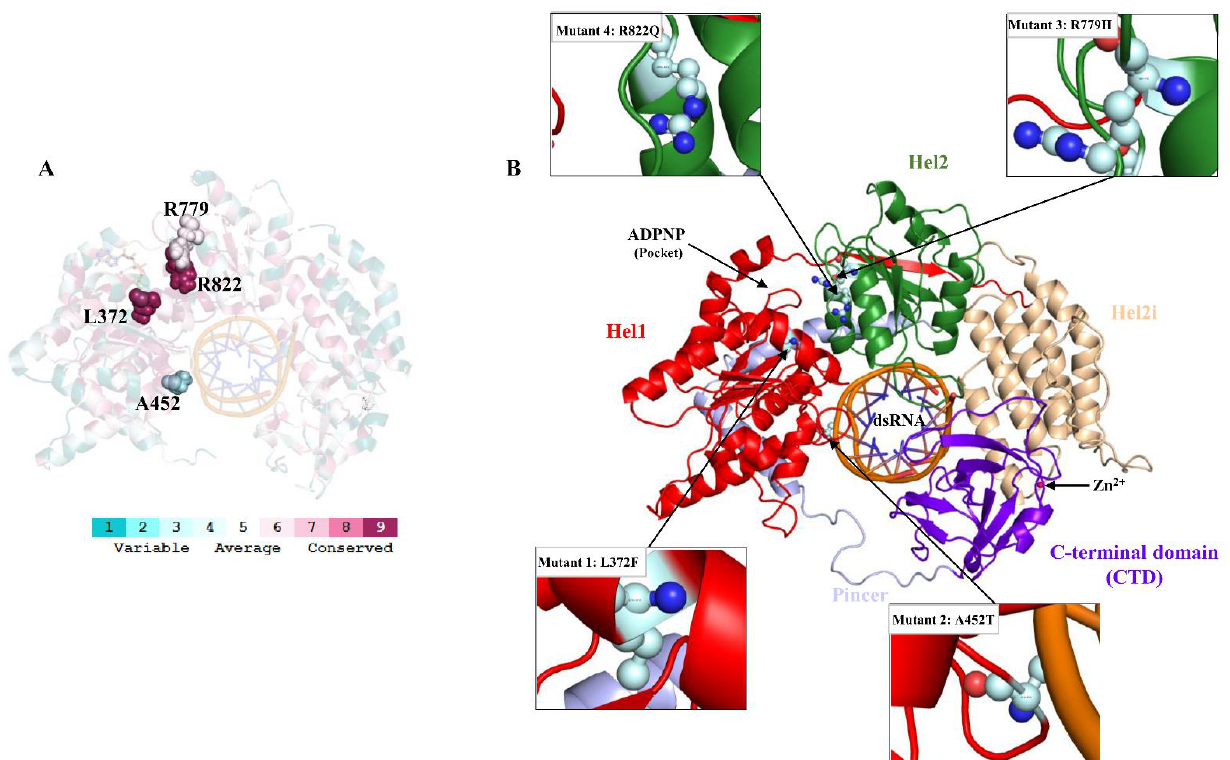
Figure 1. The structure of MDA5. ( A ) The MDA5 structure is shown with evolutionarily conserved residues. The MDA5 sequence/structure was used for conservation analysis. Residues are shown with sphere models according to the scale bar. ( B ) The structure of MDA5 with modelled missing residues. Domains of MDA5 are represented with different colors and labelled. Mutant locations are shown using ball and stick models (cyan color). Zn ion is shown using a sphere model.